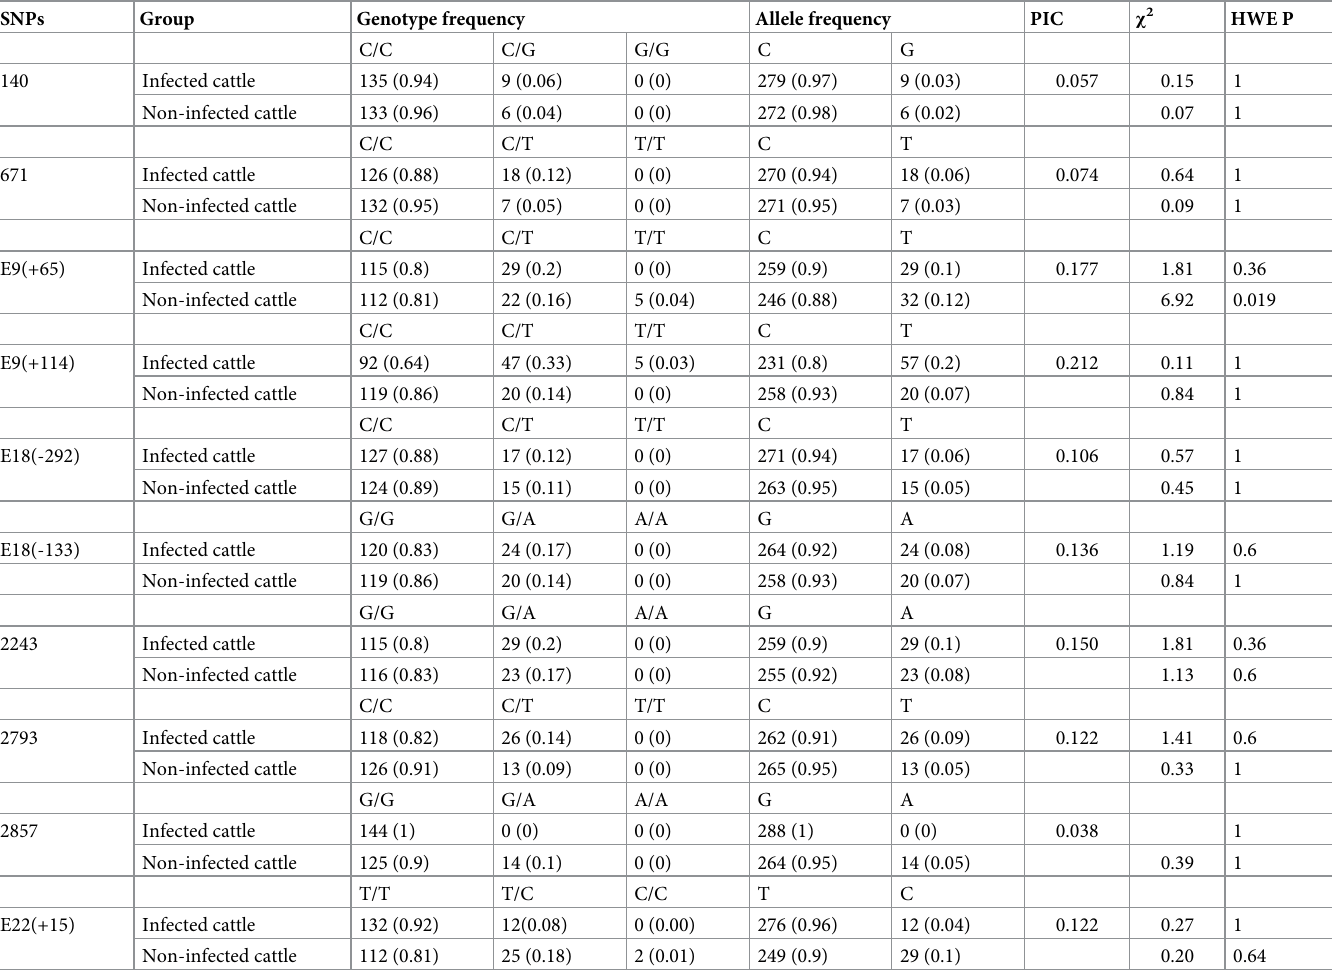
Table 3. Distribution of 10 polymorphic genotypes and allele frequency in bTB-infected cattle and controls.